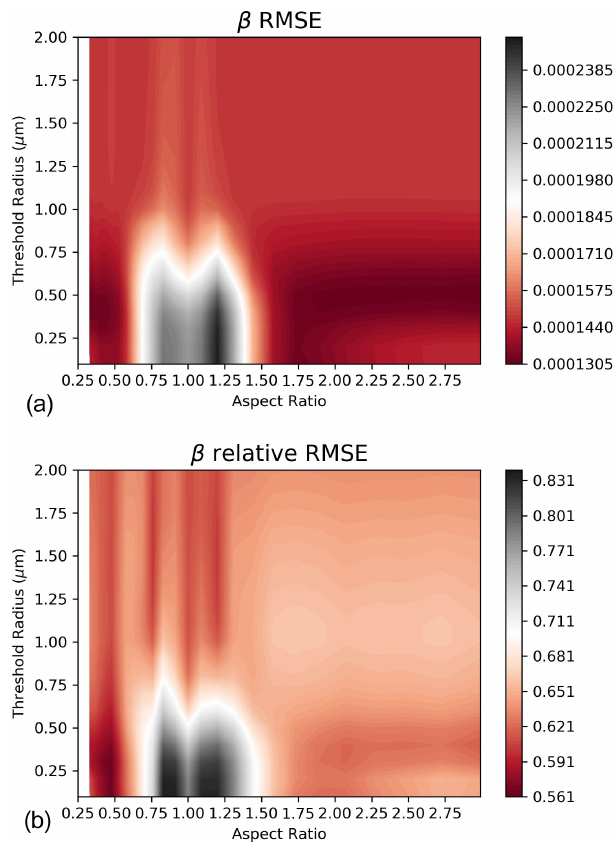
Figure 2. Contour plot of the RMSE (a) and relative RMSE (b) of the measured and modelled aerosol backscatter coefficient β A